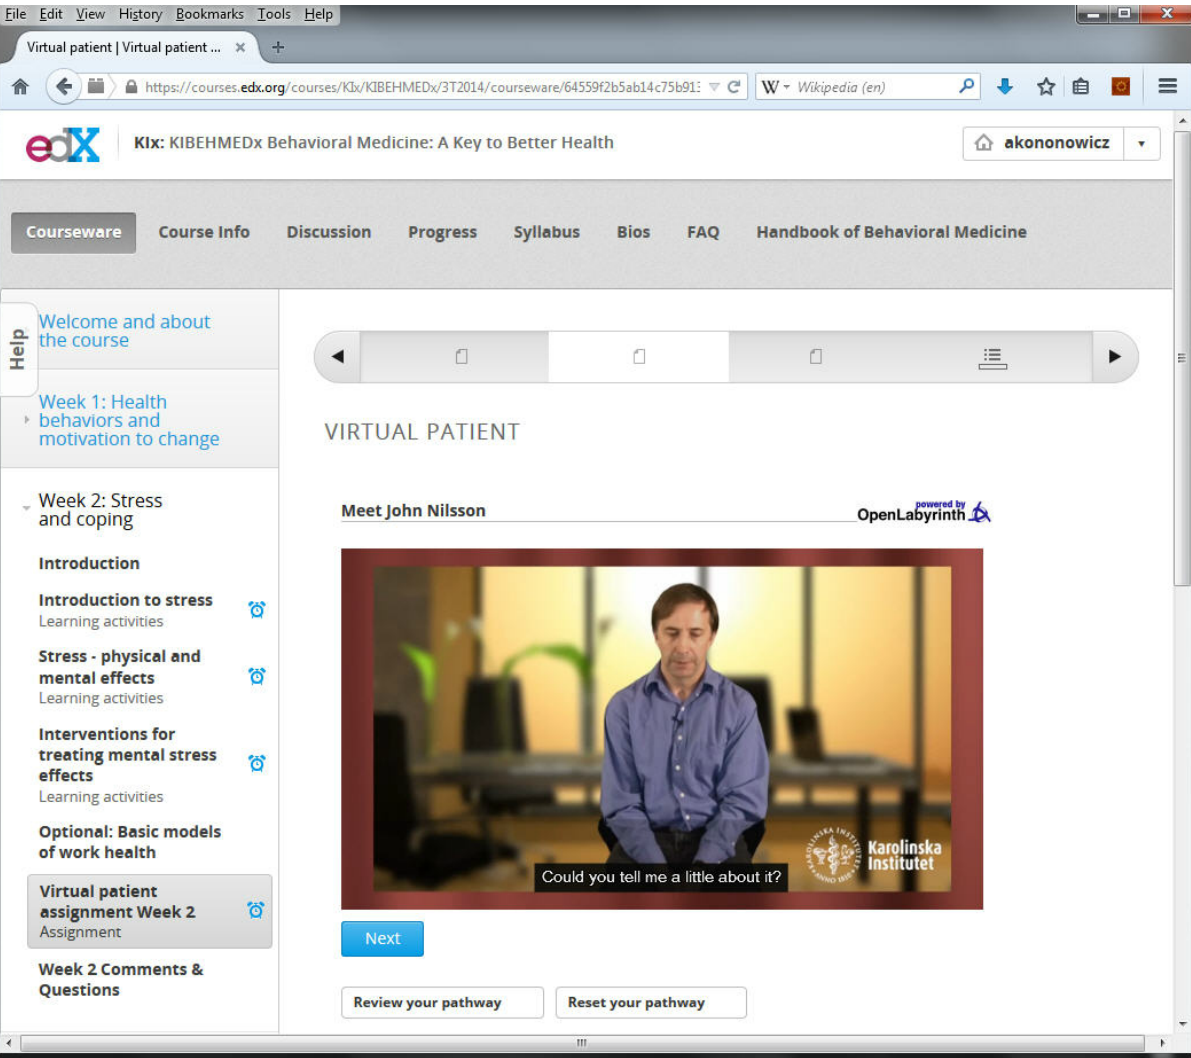
Figure 1. Virtual patient presented in the edX Behavioral Medicine